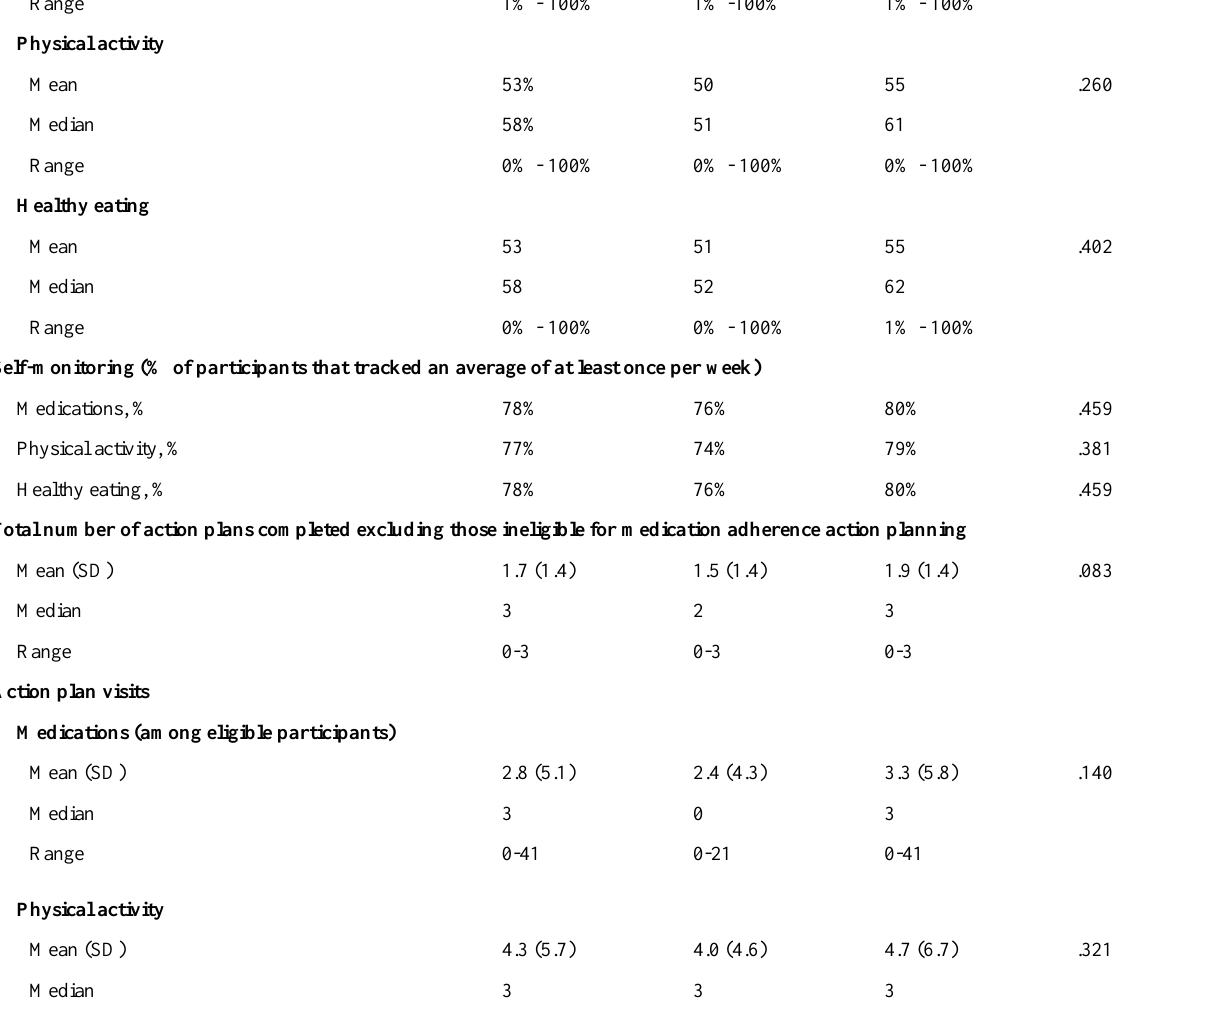
P ValueWebsite Plus